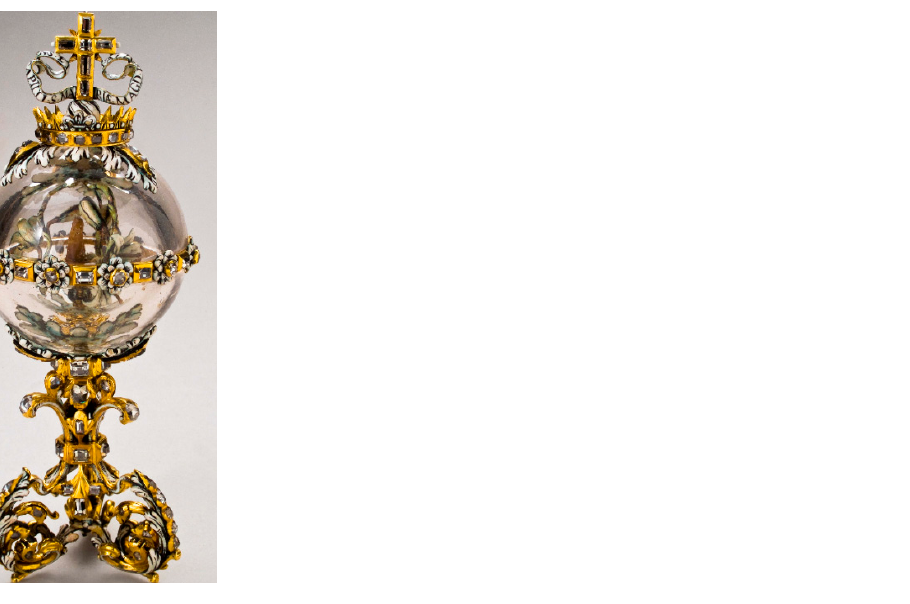
Figure 10. Giovanni Comparini, Giuseppe Vanni, Giuseppe Antonio Torricelli, and Grand Ducal Galleria . Reliquary of St. Maria Maddalena de’ Pazzi, 1682. Church Heritage Museum, Vilnius. Im- age in the public